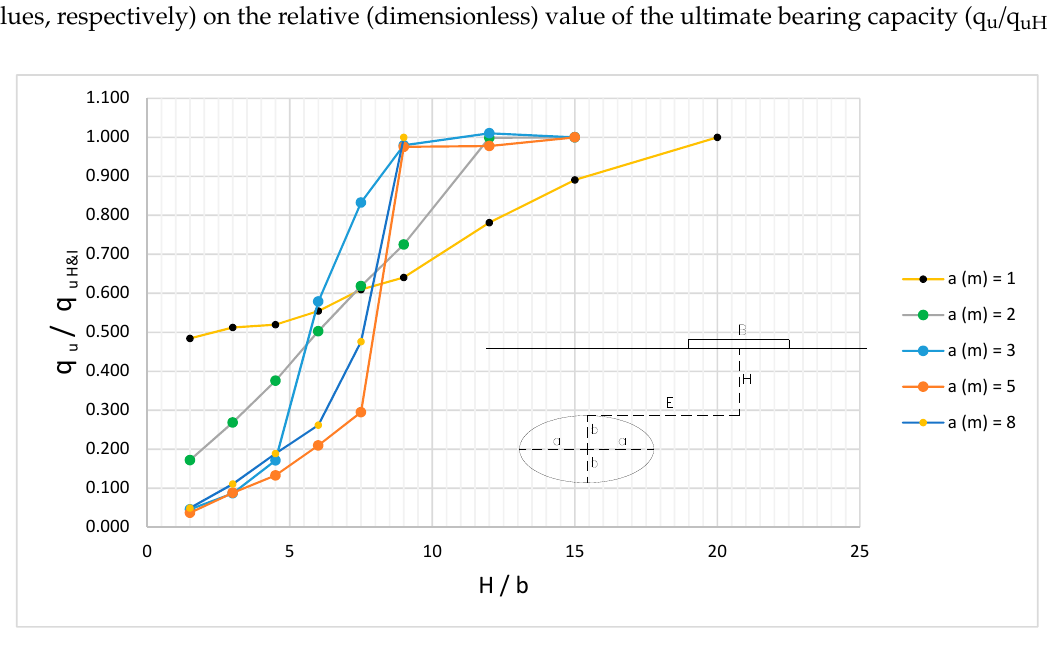
Figure 13. Influence of the relative depth of the cavern (parameter H/b) on the ultimate bearing capacity value when varying the load eccentricity.